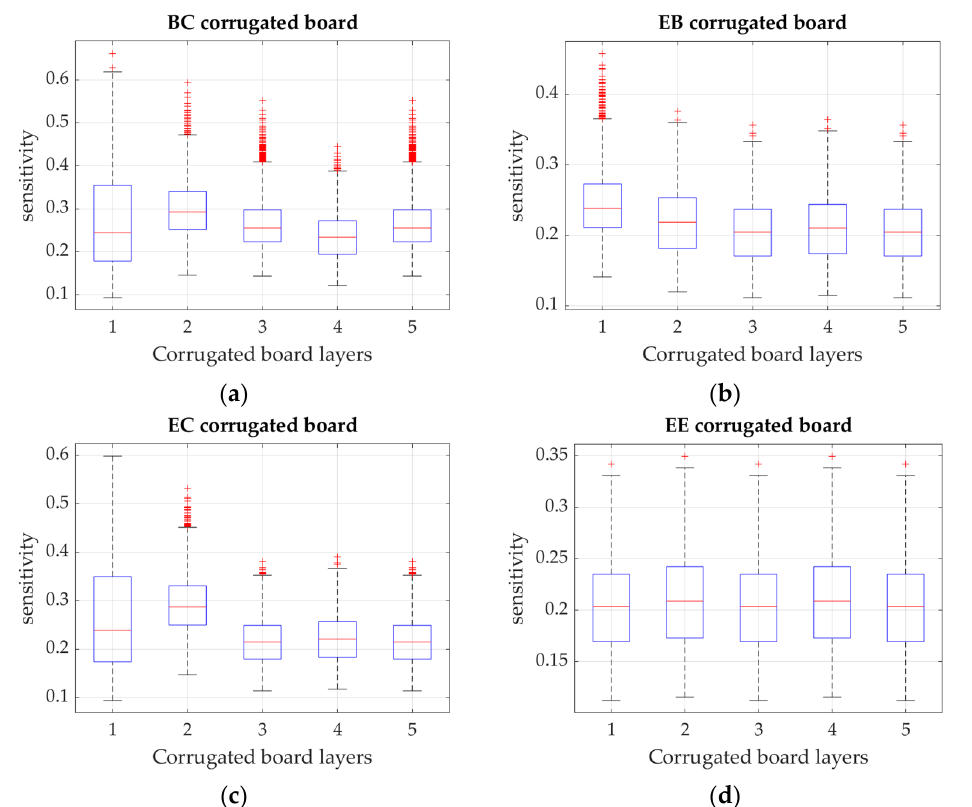
Figure 5. Sensitivity of ECT in relation to the layer grammage perturbation (1–bottom liner, 2–higher flute, 3–middle liner, 4–lower flute, 5–upper liner) for: ( a ) BC, ( b ) EB, ( c ) EC, and ( d ) EE corrugated cardboard.